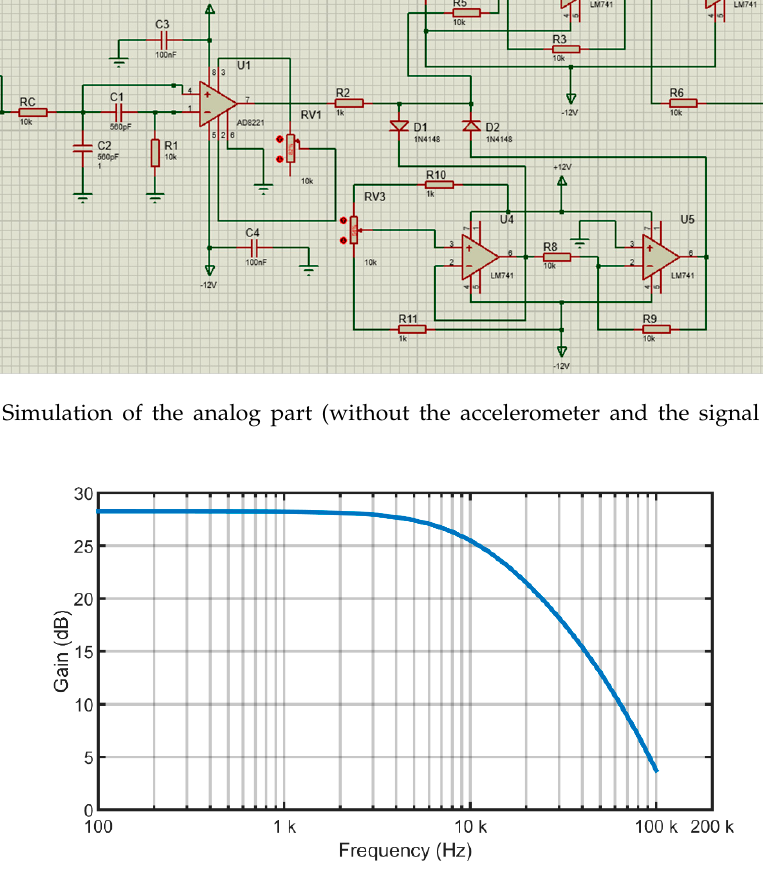
Table 4. Comparison of the Frequency Response values of the developed and the commercial device system NI DAQ 9775